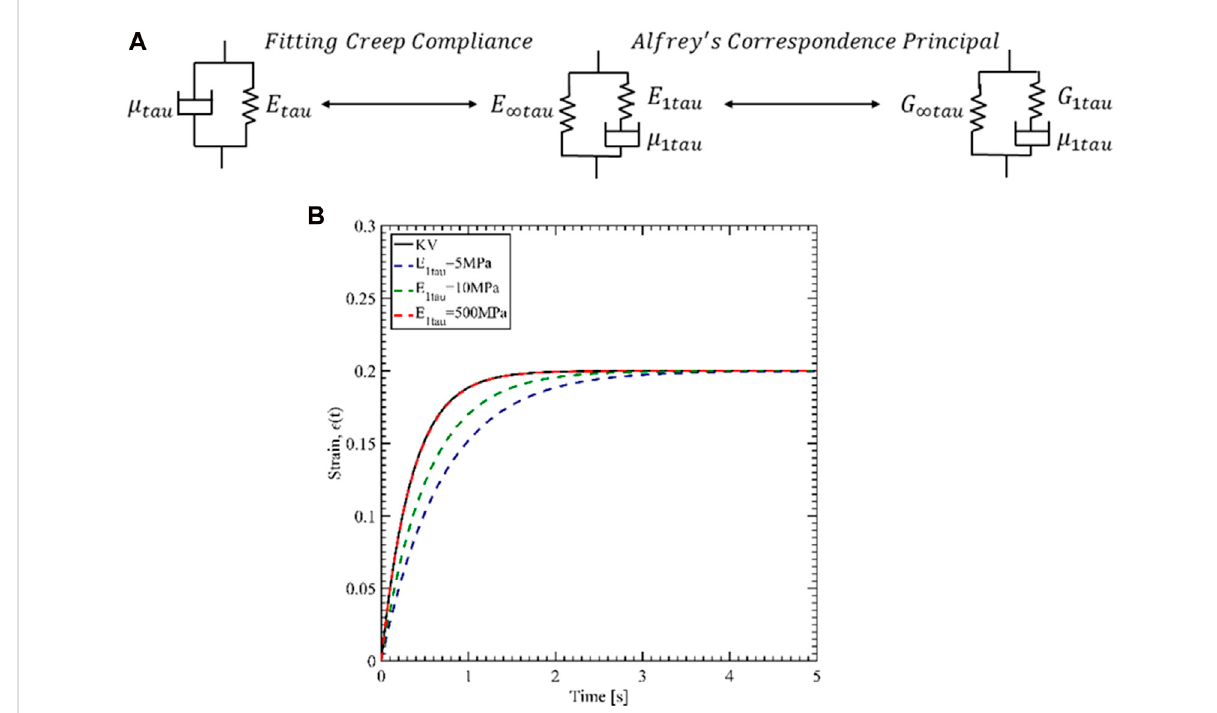
FIGURE 3 (A) Procedure of de fi ning the Tau properties for ANSYS. (B) Creep response fi t of 3-parameter General Maxwell to